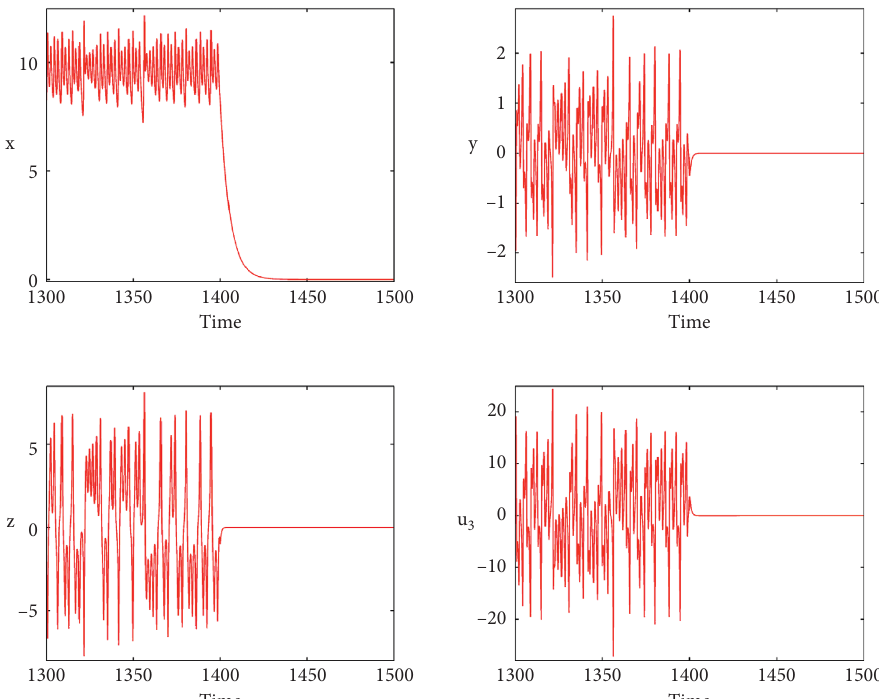
Figure 6: Time series of x,y, z , u for a � 3, b � 0 . 2 and c � 22. The initial conditions are (x(0), y(0), z(0)) � (0.1, 0.2, 0.2). 3